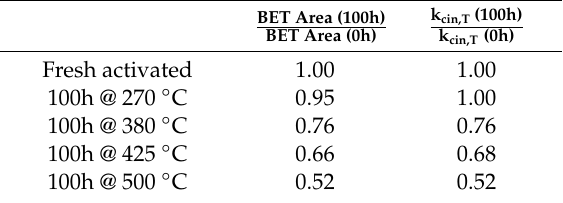
Table 4. Fitting results of the integral operating reactor and comparison with surface area ratios.